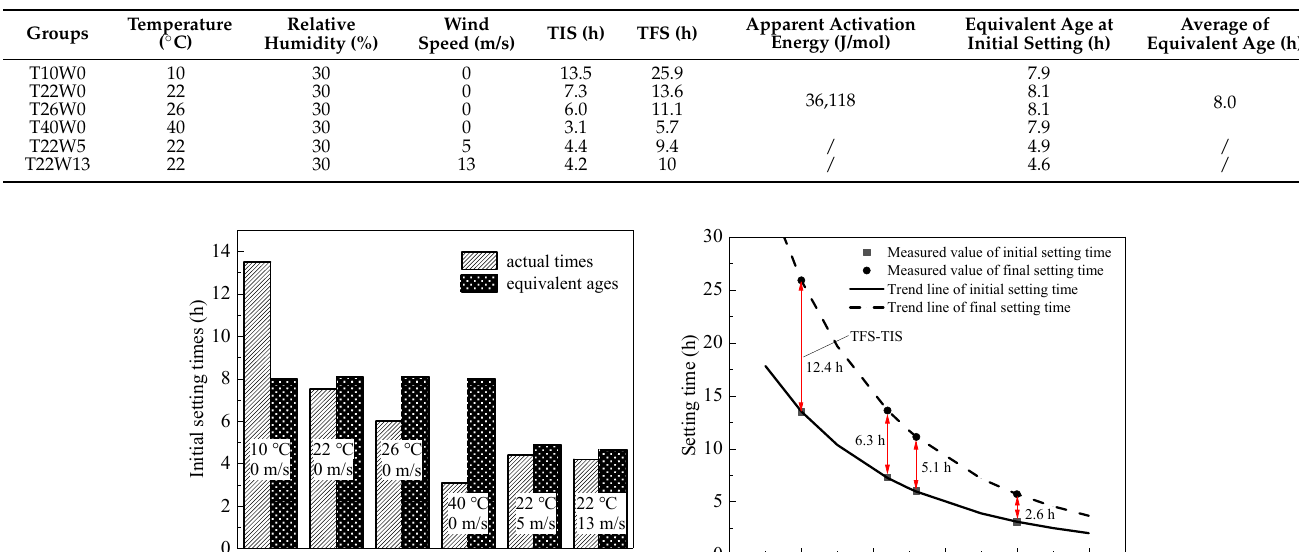
Table 5. The equivalent age of concrete at an initial setting under constant temperature.